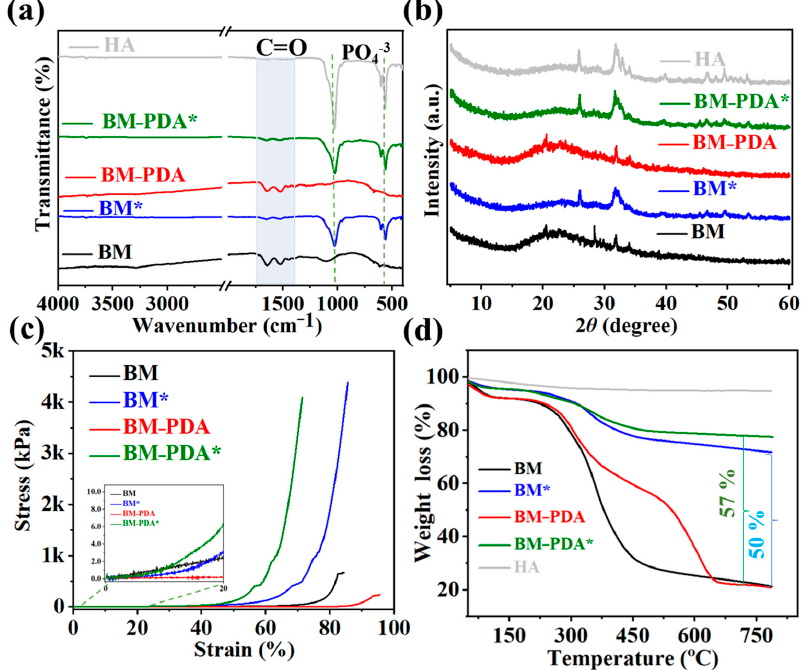
Figure 5. Structural characterization of the pristine and mineralized scaffolds by ( a ) FTIR, ( b ) XRD, ( c ) Stress-strain profile (inset shows the modulus calculation within the strain of 0–20 (%)), and ( d ) TGA.